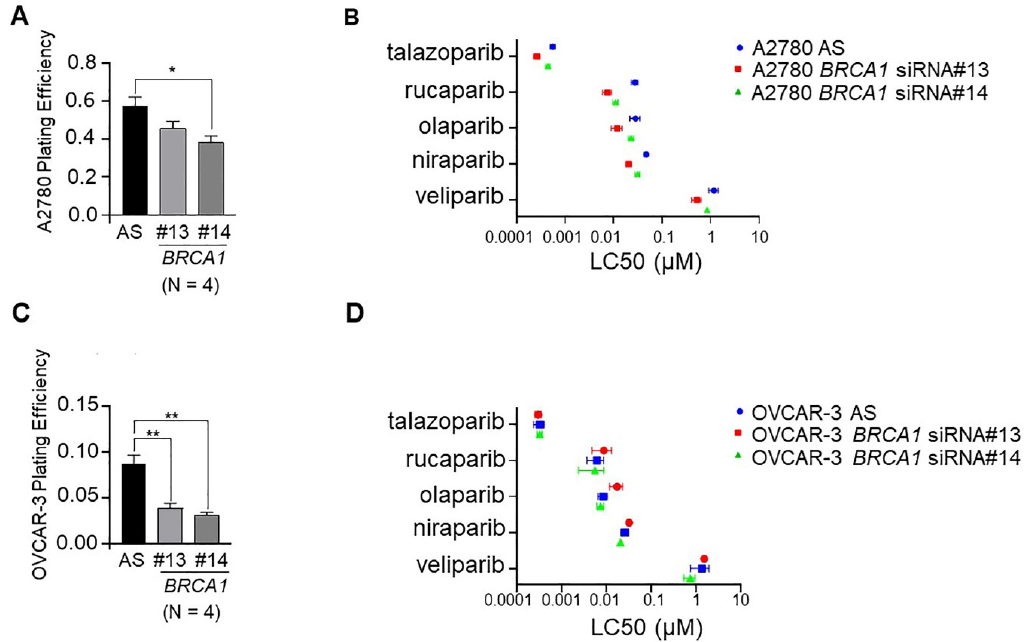
Figure 4. Down-regulation of BRCA1 decreased basal cell survival, and in some cases, sensitised cells to PARP inhibition. Down-regulation of BRCA1 by two distinct siRNAs (#13 and #14) in ( A ) A2780 cells and ( C ) OVCAR-3 cells decreased plating efficiency (N = 4; AS, AllStars control siRNA). LC50 data calculated from cell survival (clonogenic assay) for each of the five PARPis (niraparib, olaparib, rucaparib, talazoparib and veliparib) after BRCA1 down-regulation in ( B ) A2780 cells and ( D ) OVCAR-3 cells. * p < 0.05, ** p < 0.01.